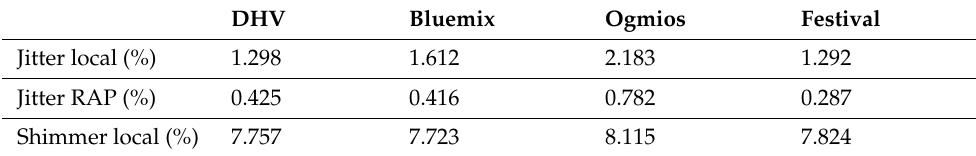
Table 4. Average jitter, jitter RAP, and shimmer (in %) from samples at 50% reduced speed. DHV Bluemix Ogmios Festival Jitter local (%) 1.16 1.39 1.91 1.05 Jitter RAP (%) 0.37 0.35 0.67 0.23 Shimmer local (%)